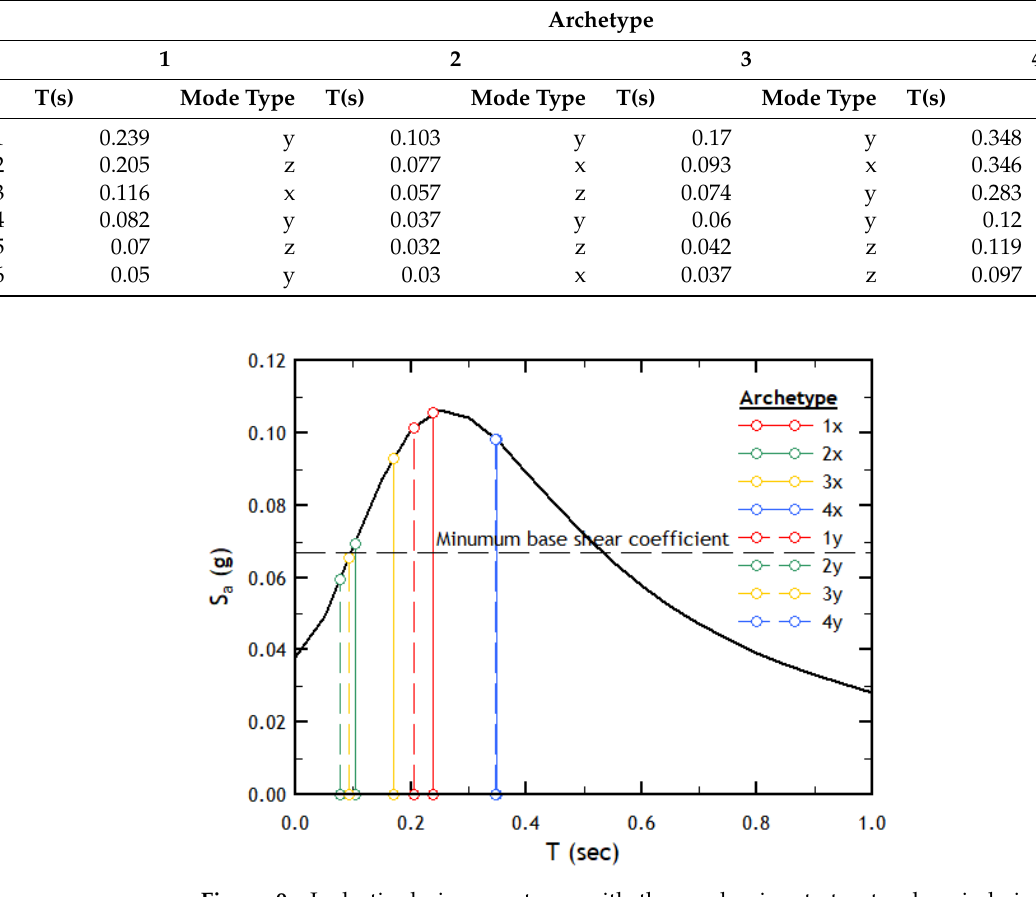
Table 4. Torsional properties of the archetypes.